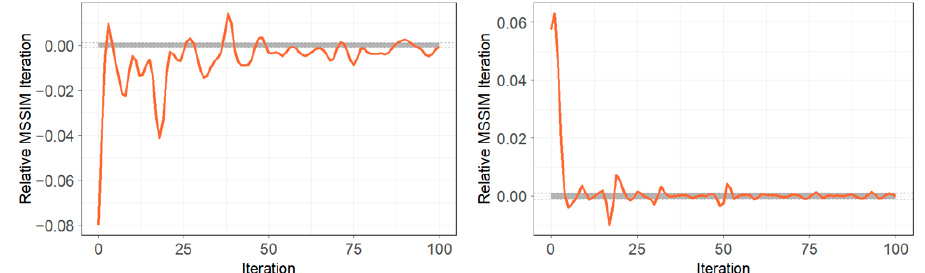
Figure 7. Relative changes of the MSSIM according to Equations (19) and (20) for the data-driven results when w 2 = 1. The performed band used ε = 10 − 3 .